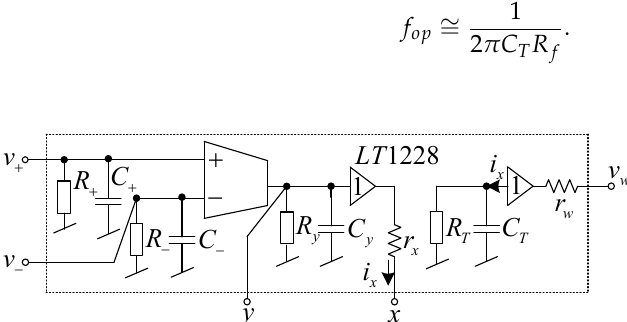
Figure 4. The LT1228 circuit model with parasitic elements.